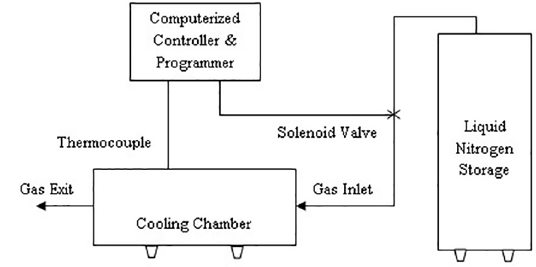
Figure 2. Schematic overview of